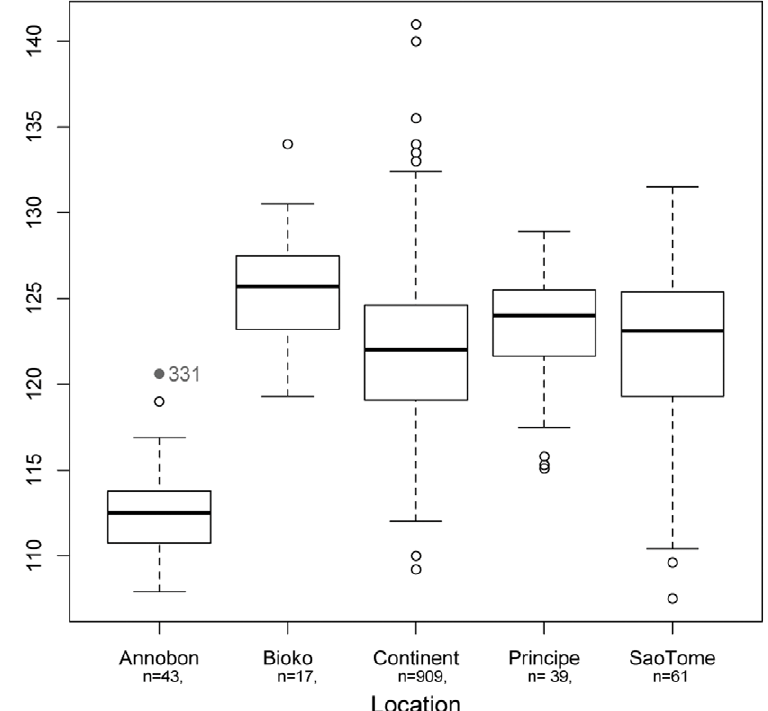
Figure 3. Forearm length of adult Eidolonhelvum bats. Values are compared among populations in the four Gulf of Guinea islands and continental Africa. Graphs are of box and whisker plots showing median (black line), 25 th and 75 th percentile (box) and 1.5x the interquartile range (dotted line) values. doi:10.1371/journal.pone.0030346.g003 PLoS ONE |